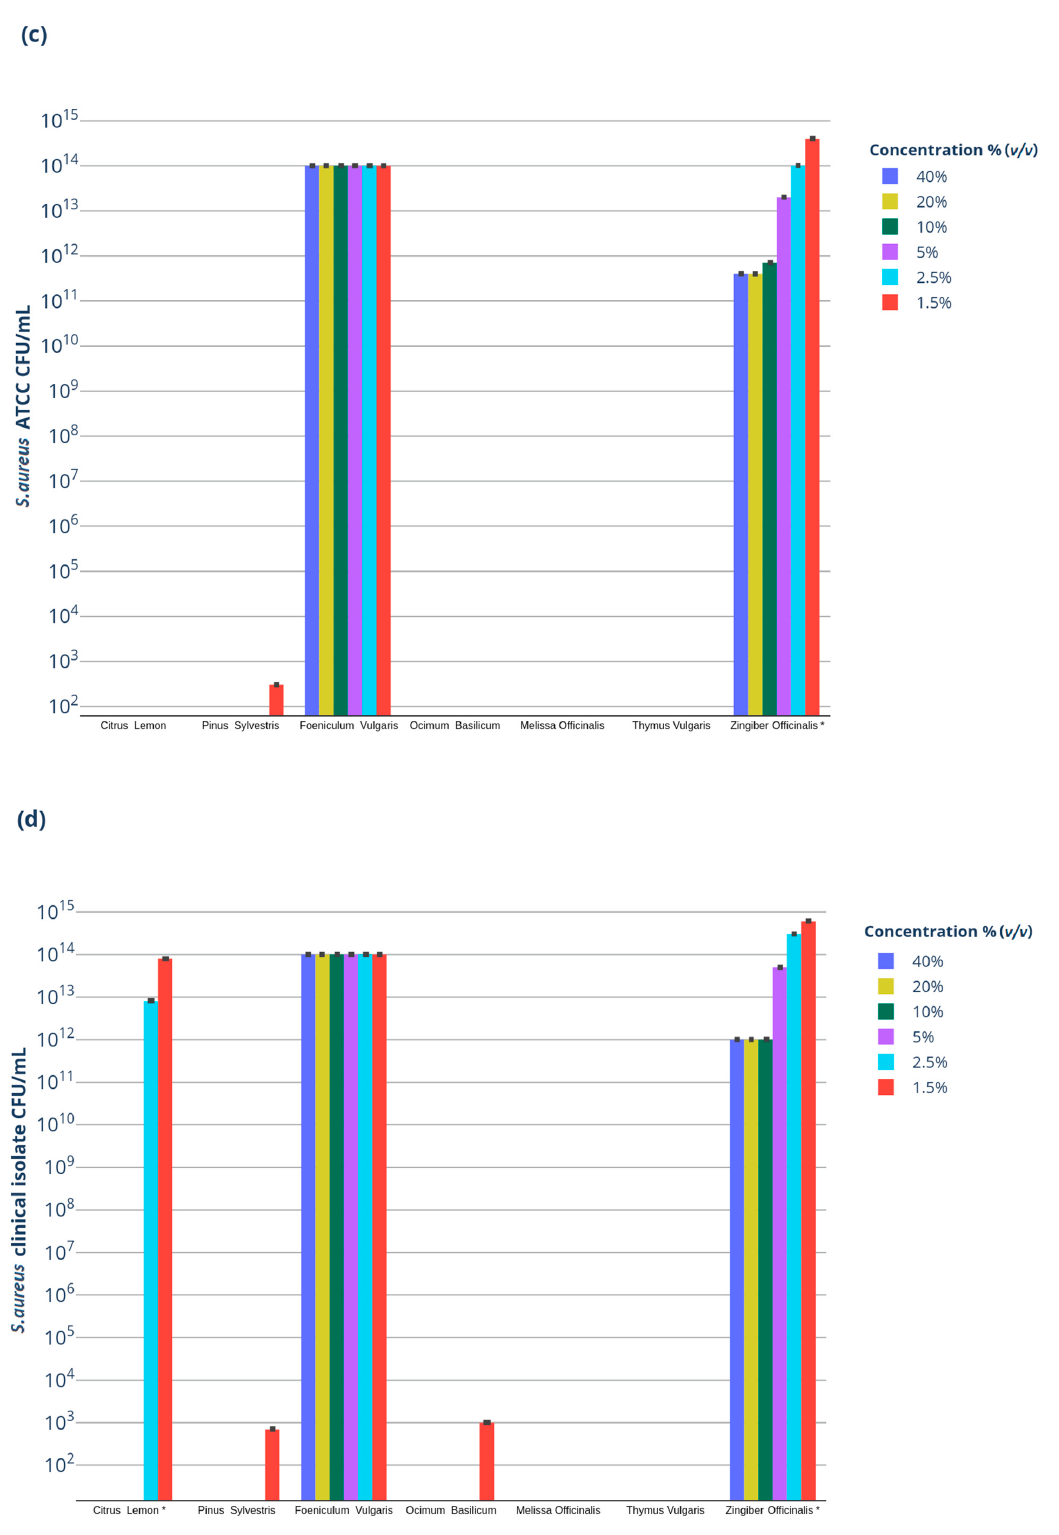
Figure 1. Bacterial growth of the tested strains. Response of bacterial strains in MH broth with varying percentages ( v / v ) of different EOs after 24 h of incubation, expressed as the rate of growth reduction in CFU/mL compared to positive controls. *: statistically significant dose–effect correlation ( a ) E. coli ATCC; ( b ) E. coli clinical isolate 462/20; ( c ) S. aureus ATCC; ( d ) S. aureus clinical isolate